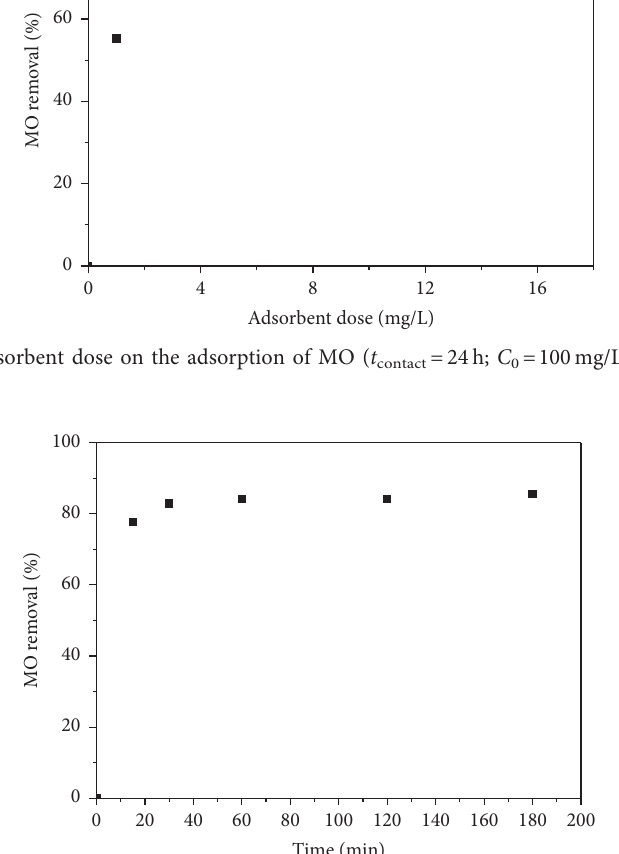
� 100mg/L; adsorbent dose � 16g/L; pH � 7.21; T � 22 ° 0 removal). Therefore, the pseudo-second-order model can describe the adsorption process of MO onto sugar scum powder. These results suggest that the boundary layer